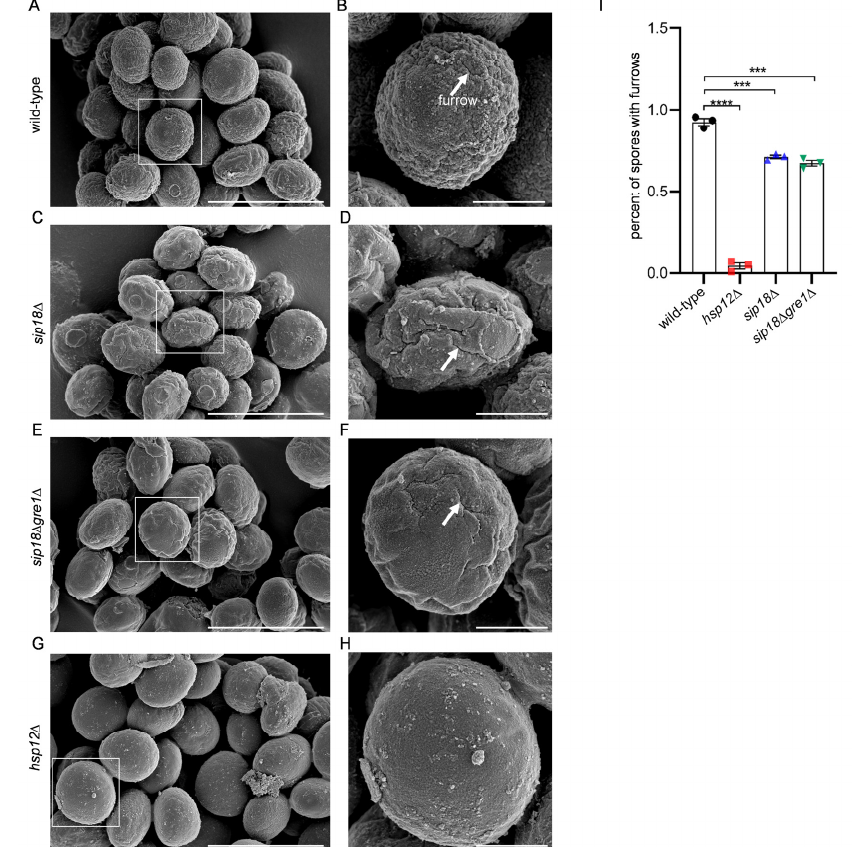
Figure 5. FESEM analysis of hydrophilin mutant spores. ( A , C , E , G ) Wild-type sip18 ∆ , sip18 ∆ gre1 ∆ , and hsp12 ∆ spores, respectively. ( B , D , F , H ) Close-up of the boxed areas in ( A , C , E , G ), respectively. ( A , C , E , G ) Scale bar, 5 μ m. ( B , D , F , H ) Scale bar, 1 μ m. Arrows indicate furrows. ( I ) Quantification of spores with furrows. Data are presented as the mean ± SEM. Statistical significance was determined by two-tailed unpaired Student’s t -tests. n = 3 ( I ). ***, p < 0.001; ****, p < 0.0001.